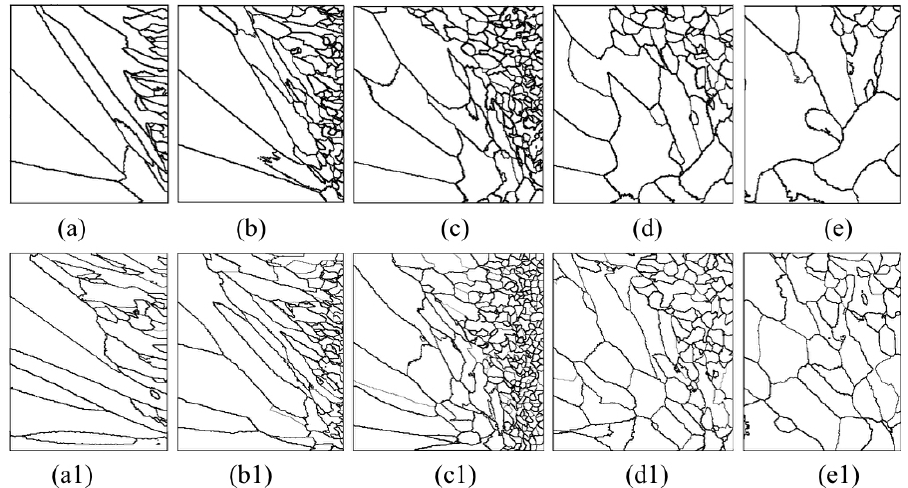
Figure 15. Microstructure morphology predicted of different axial sections with the cooling temper- ature of − 78 °C ( a – e : without nickel coating; a1 – e1 : with nickel coating). The microstructure morphology of the different radial sections is presented in Figures 17 and 18. When slices are away from the cold end (from slice (a) to slice (e), as shown in the right picture of Figure 13), the grains will gradually become equiaxed grains at the edge of the slice. On the contrary, the grains will develop columnar crystals at the center of the section (near the carbon fiber). The reason for this situation is that the crystal growth direction is always in the opposite direction of heat